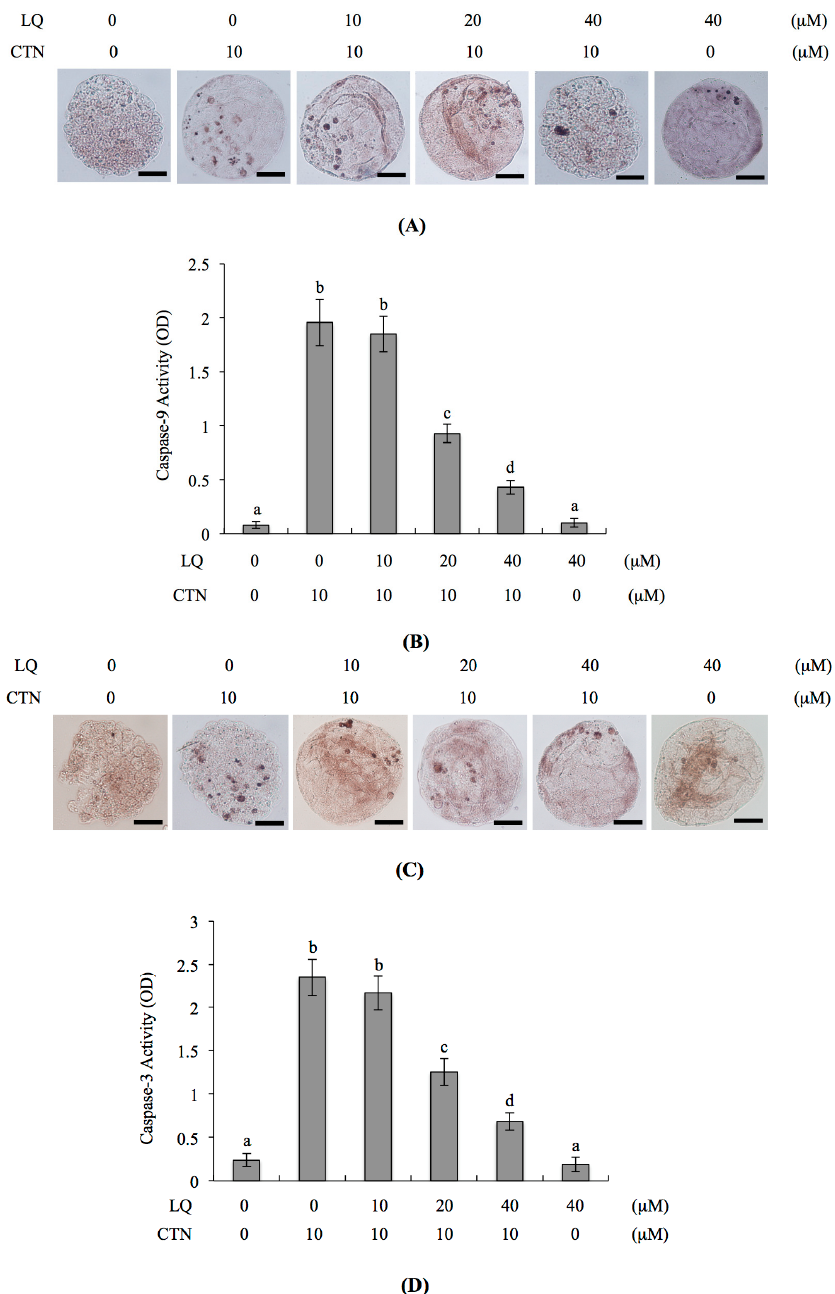
Figure 5. Effects of LQ on caspase-9 and caspase-3 activities in CTN-triggered mouse blastocysts. Mouse blastocysts were preincubated with LQ (10–40 μ M) for 1 h. Embryos were further treated with or without 10 μ M CTN for 24 h. ( A , C ) Activation of caspase-9 and caspase-3 was analyzed by immunostaining with caspase-9 and caspase-3 antibodies for 3 h, followed by secondary antibodies conjugated to peroxidase for 1 h. Diaminobenzidine (DAB) solution was added to embryos as the peroxidase substrate for color rendering. Activated caspase-9 and caspase-3 are presented in black; ( B , D ) Activities of caspase-9 ( B ) and -3 ( D ) of blastocysts were measured using the caspase assay kit. Data are expressed as arbitrary units. Values are presented as means ± SD of five determinations. Different symbols indicate significant differences at p < 0.05. The scale bar is 20 μ m.